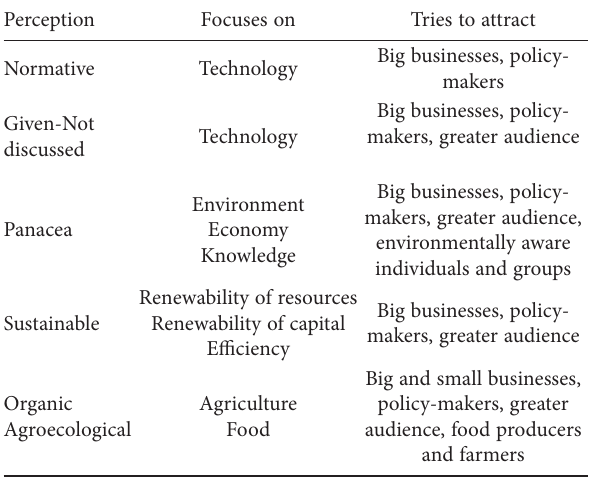
Table 3. Academic discourse on the bioeconomy. This table is a visual presentation of basic perceptions of the bioeconomy as pre- sented in academic literature. For sources, see the